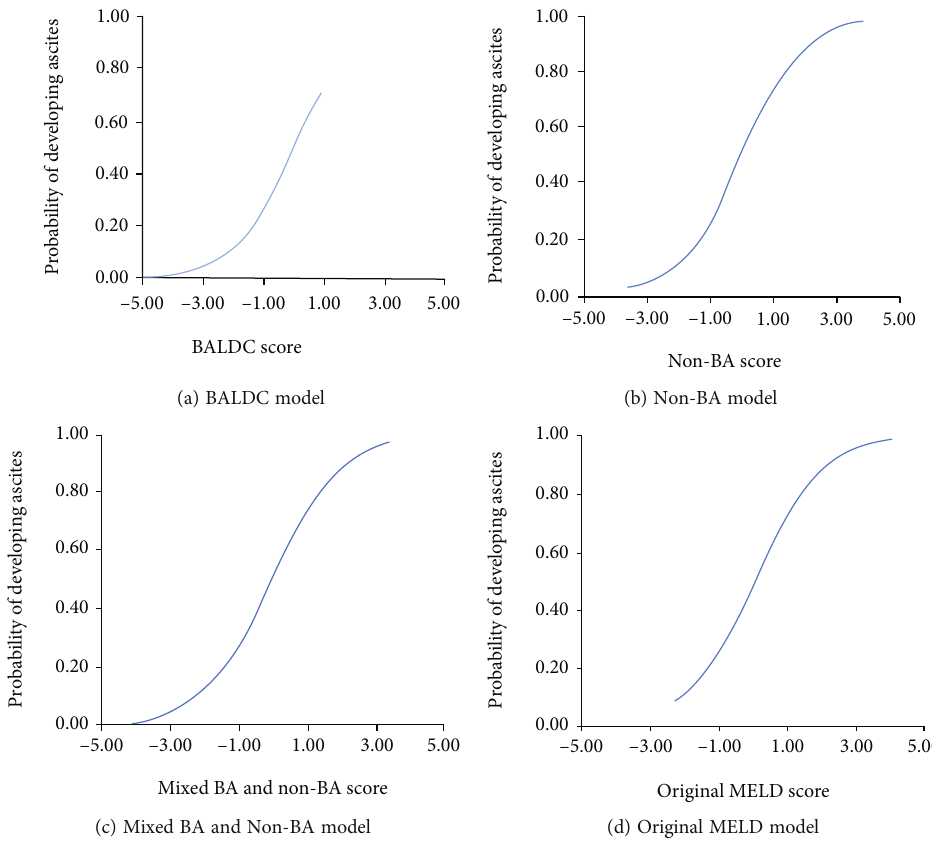
Figure 1: The relationship between the BALDC, non-BA, mixed BA and non-BA, and original MELD model scores and the probability of developing